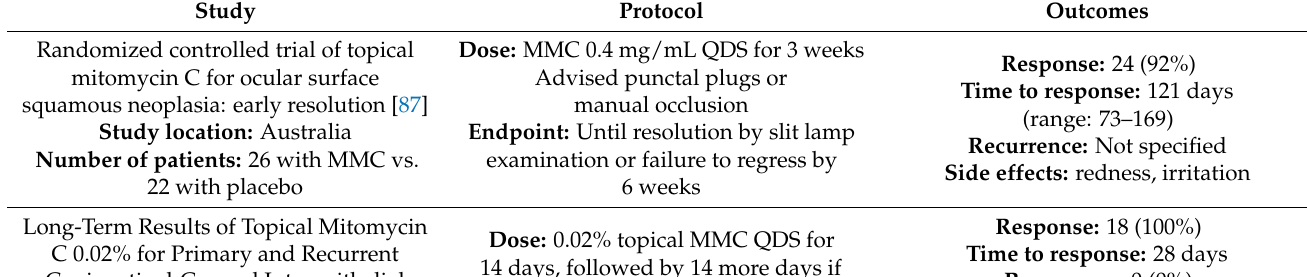
Table 2. Summary of study protocols using Mitomycin C (MMC) as sole treatment of OSSN. Study